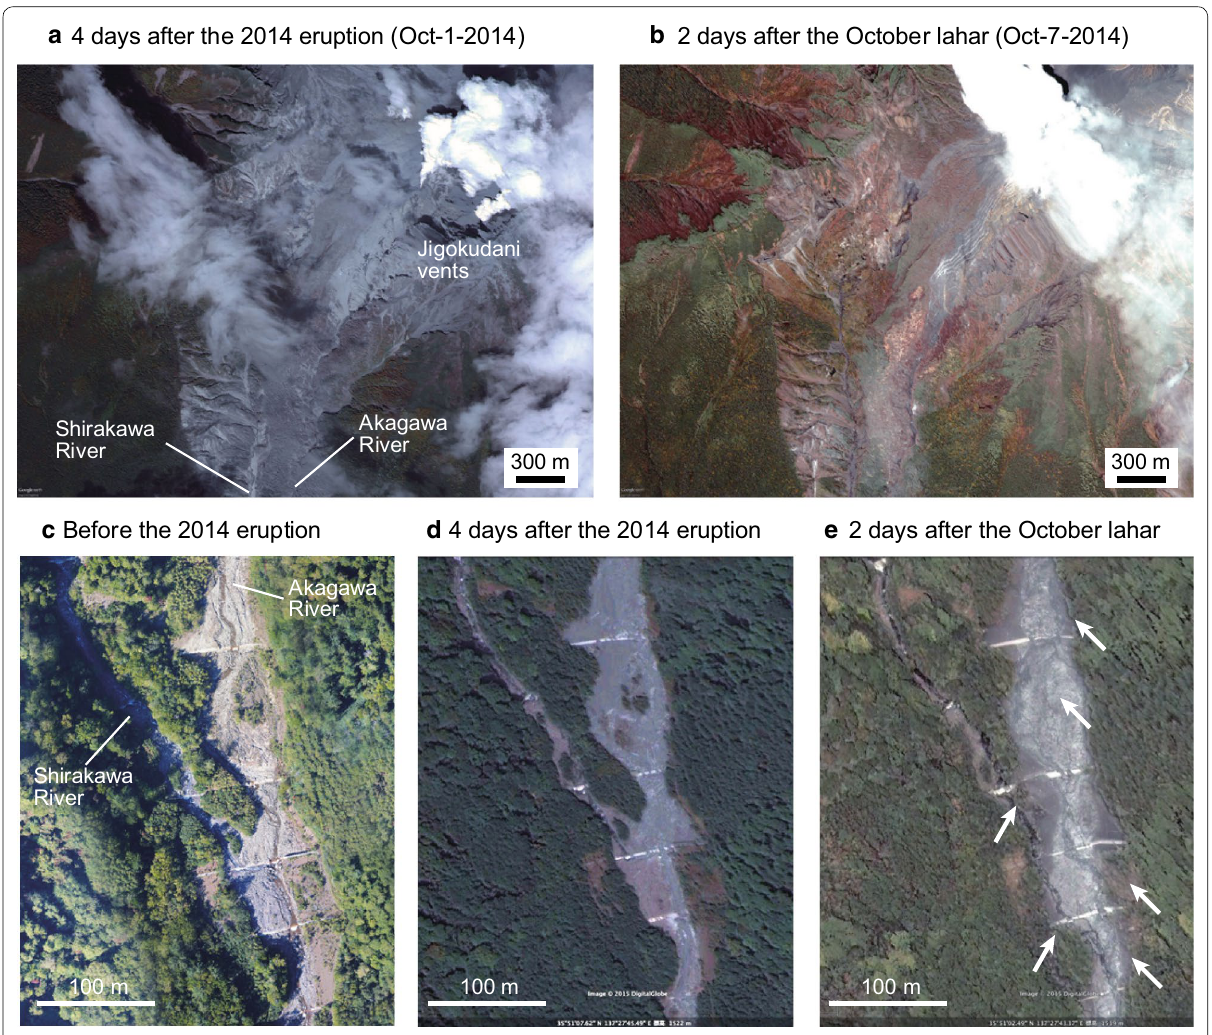
Fig. 3 Aerial photographs of the catchment of Akagawa and Shirakawa Rivers. a Google Earth image captured immediately after the eruption (on October 1, 2014) and b October 7, just 2 days after the rain-triggered lahar occurred on October 5 in the upstream and summit areas. Much of the slope-covered ashfall materials were swept away by the rainstorm. c Picture taken before the 2014 eruption (the area captured during August to November 2013 by the Geospatial Information Authority, Japan) of the confluence area of the Akagawa and Shirakawa Rivers (the same area in d and e ). d Google Earth image captured on October 1. e Image (by Google Earth) showing the impact after the lahar (taken on October 7). Arrows indicate areas where major geomorphological changes (erosion and overbank deposition) by the lahar were